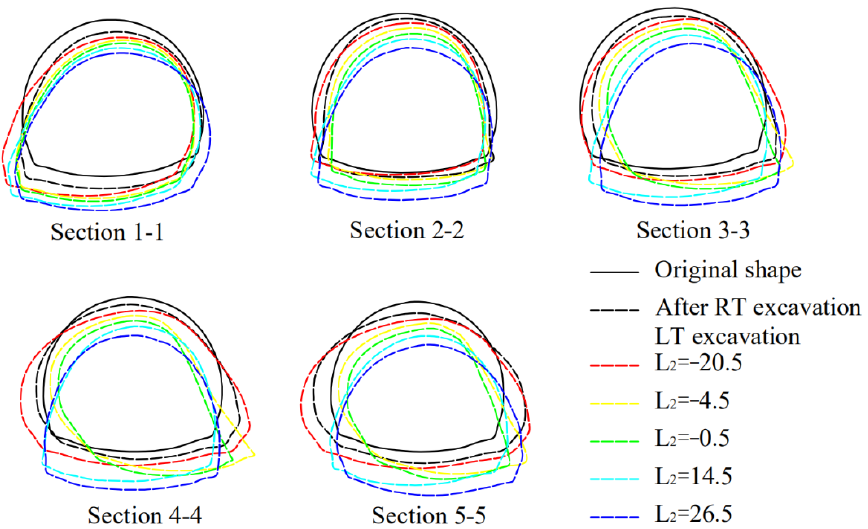
Figure 11. Transverse deformation of 5 sections during RT excavation (magnification factor f = 30,000). Note: L 1 represents the horizontal distance of the shield palm face from the existing tunnel axis during the RT excavation, L 2 represents the horizontal distance of the shield palm face from the existing tunnel axis during the LT excavation after the RT excavation is completed (as shown in Figures 9 and